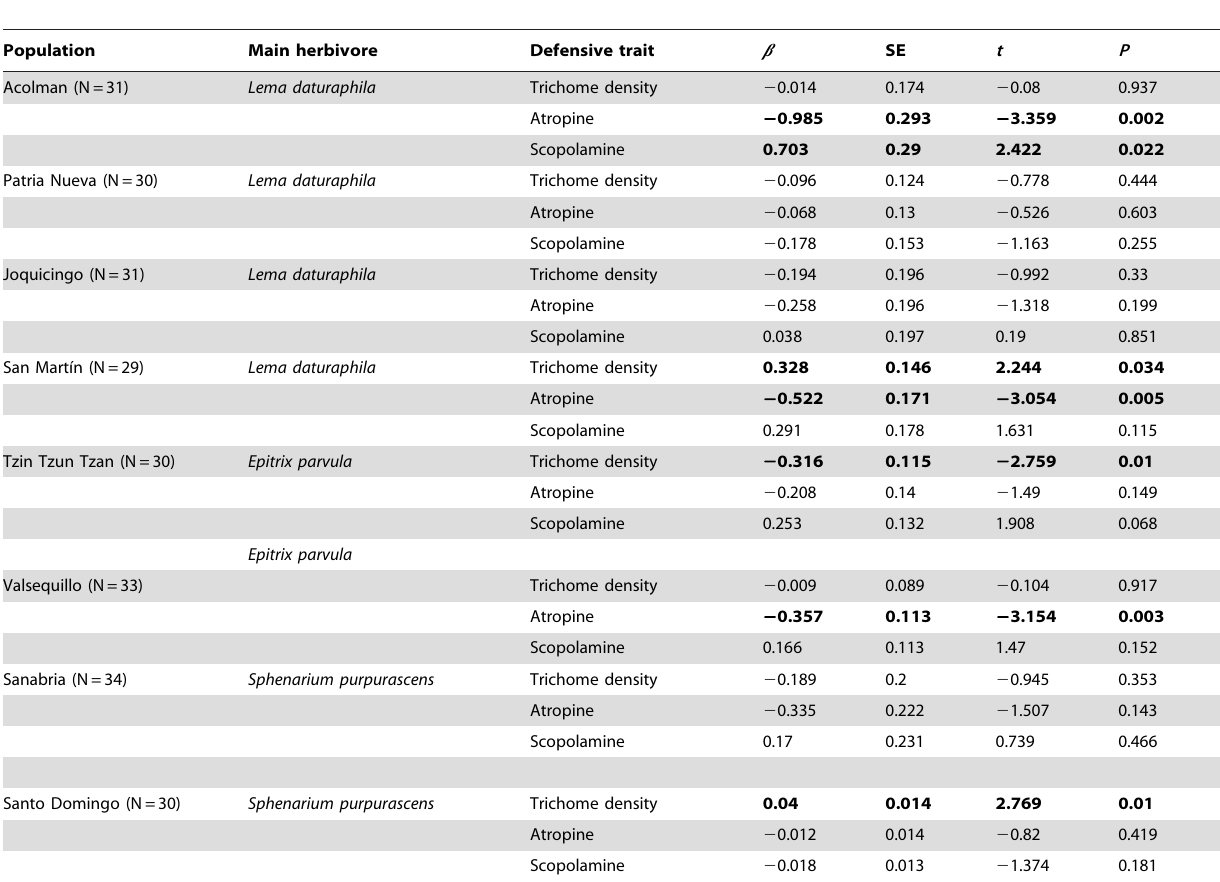
Table 2. Multiple regression analyses to estimate linear selection gradients ( b ) for trichome density, atropine, and scopolamine concentration in eight populations of Datura stramonium